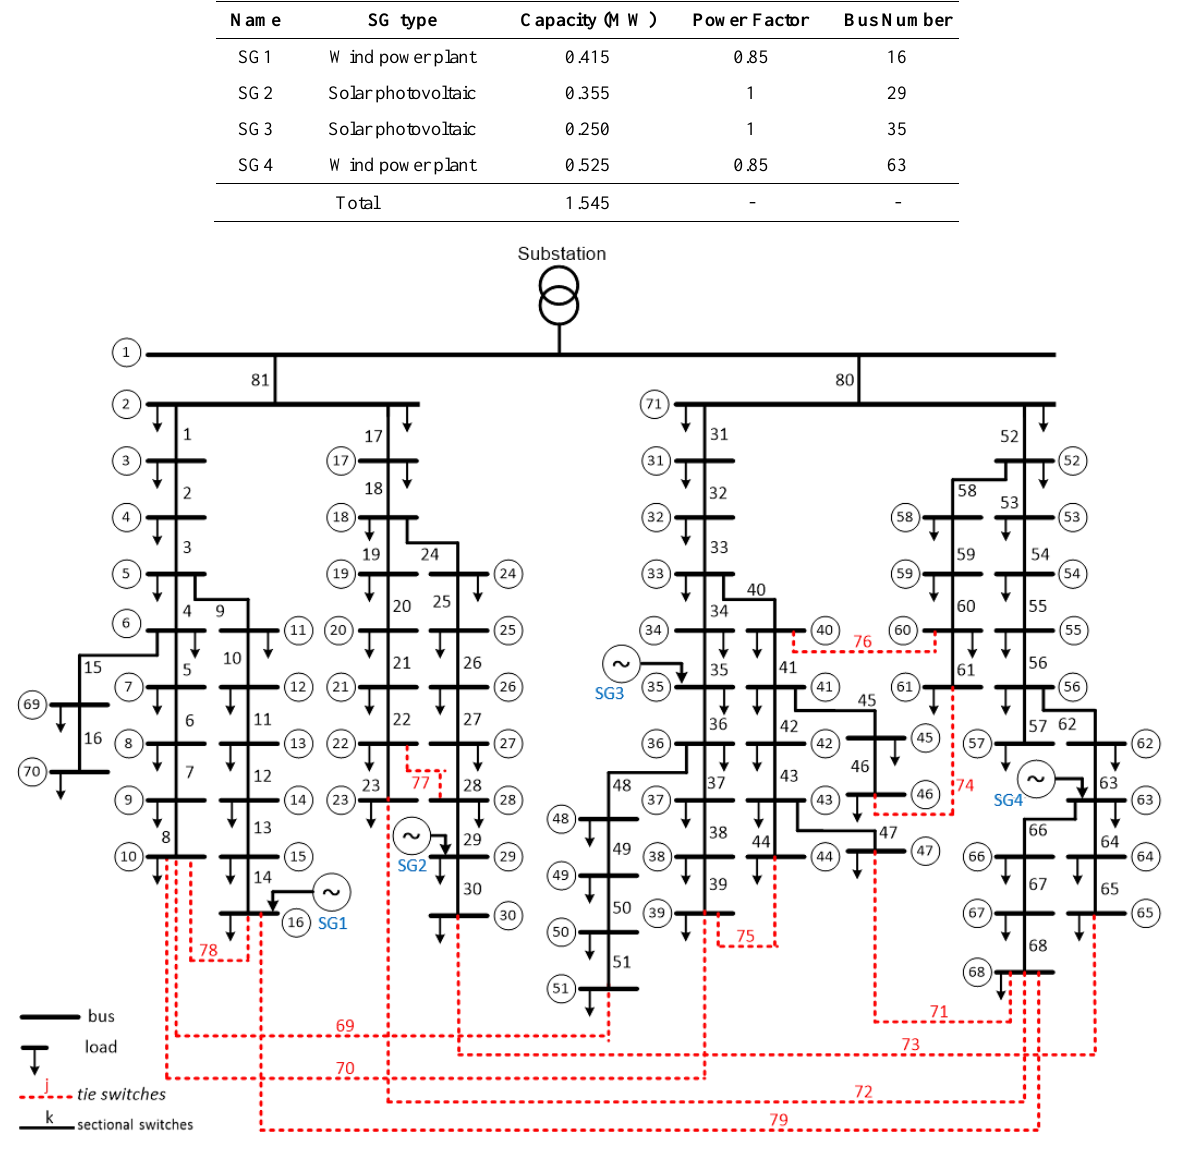
Figure 11. Installation of four SGs on IEEE model distribution network 71-bus.